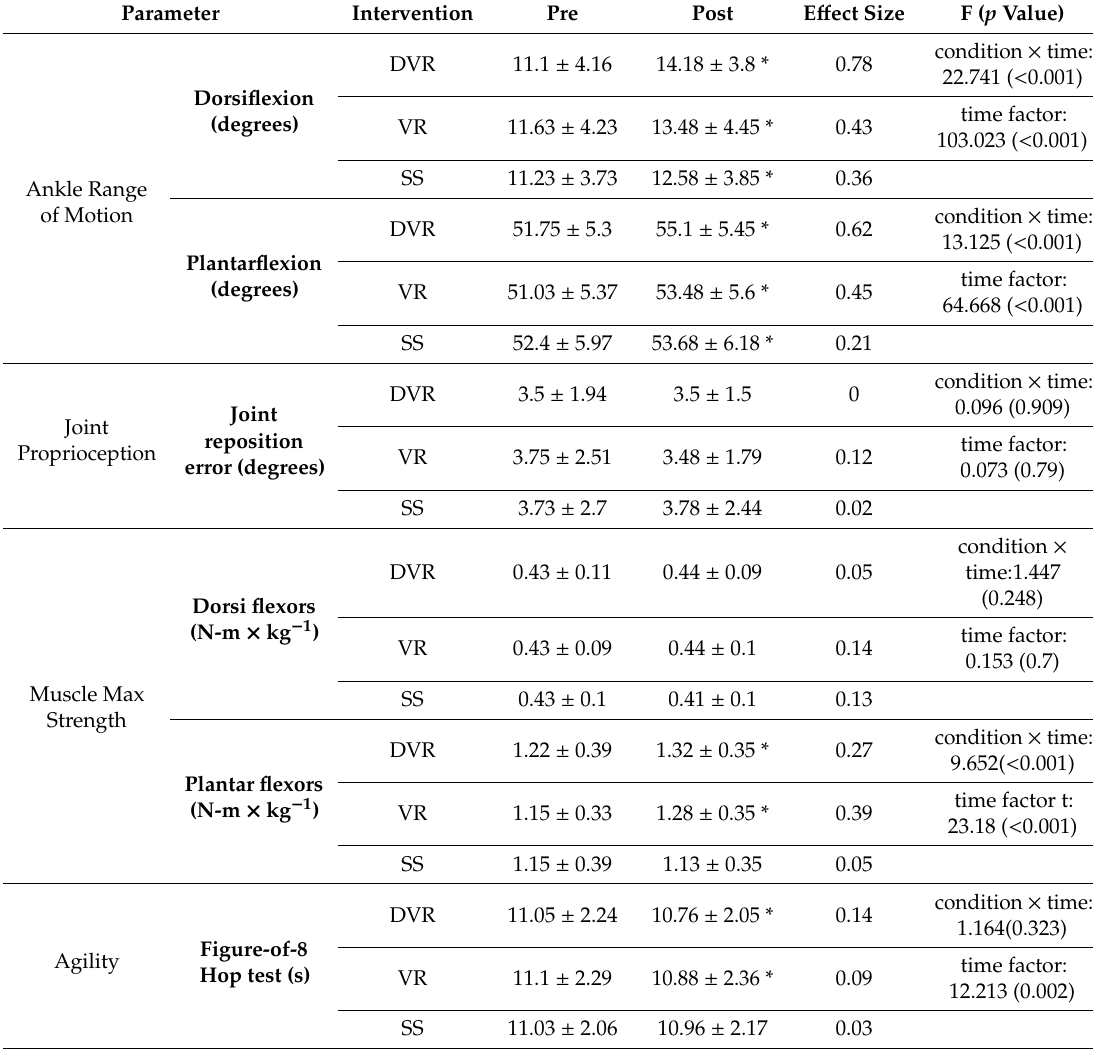
Table 1. Pretest and posttest descriptive